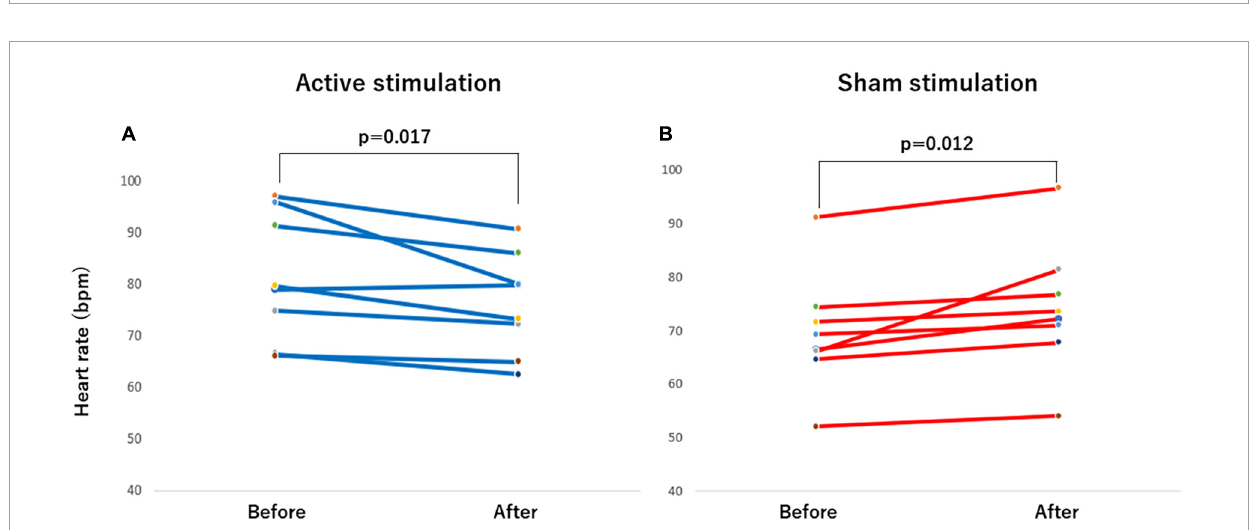
FIGURE7 Effect of active vs sham tVNS on measures of heart rate. (A) Active stimulation. (B) Sham stimulation. tVNS, transcutaneous vagus nerve stimulation.